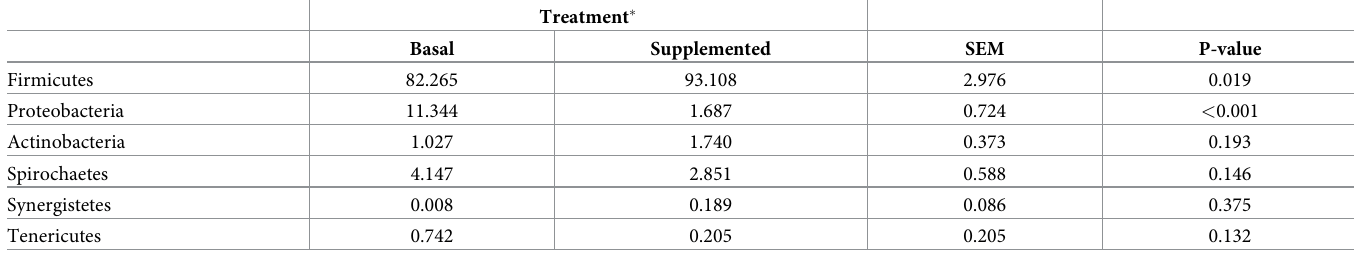
Table 5. Effect of supplementation of CH-YBG during gestation/lactation on differential relative abundance of bacterial taxa at the phylum level in sow faeces on expected farrowing date. (least-square mean values with their standard error of means). Treatment � Basal